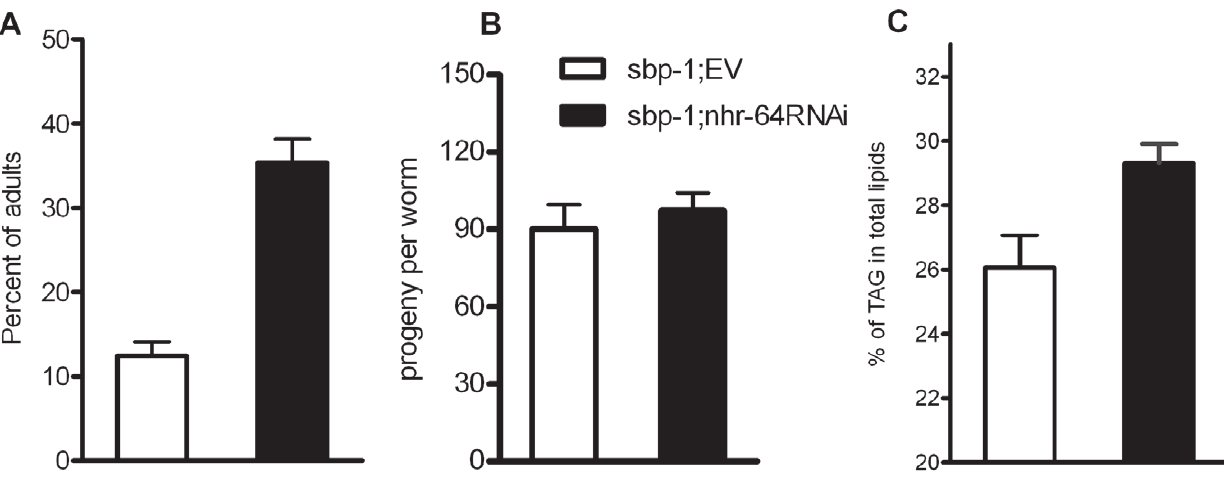
Figure 2. Inactivation of nhr-64 suppressed the growth rate and fat storage but not brood size of sbp-1(ep79) mutant. For all panels, white bars are sbp-1(ep79) ; empty vector and black bars are sbp-1(ep79);nhr-64(RNAi) grown on E. coli strain HT115. (A) Inactivation of nhr-64 improved the growth of sbp-1(ep79) animals. The number of animals that reached adult stage were counted 75 h after plating synchronized L1 larvae. 500–600 worms were scored for each genotype. Error bars are SEM. (B) The average number of progeny produced by individual sbp-1(ep79) animals treated with either empty vector (EV) or nhr-64RNAi , n=25 individuals for each treatment. Error bars are SEM. (C) Inactivation of nhr-64 increased the triacylglycerol/total lipid ratio in sbp-1 mutants. Total lipids were extracted from two independent biological replicates and separated into triacylglycerol and phospholipid fractions using thin layer chromatography and quantified using gas chromatography. Error bars show the range of two independent biological